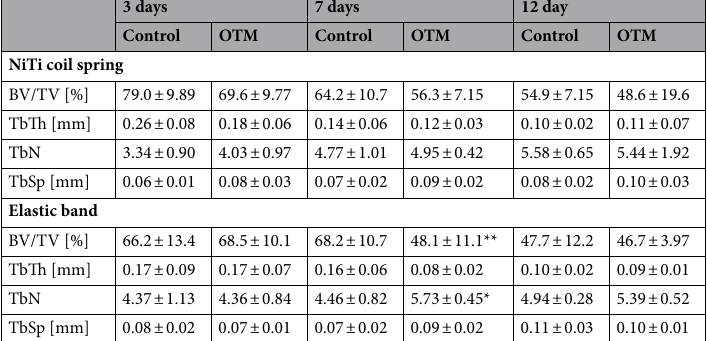
Effects of both methods for experimental OTM on bone morphogenetic factors. µCT evalu- ation showed a continuous, but insignificant decrease of the interradicular bone density (BV/TV) of the first upper left molar on the treated (OTM) as well as on the untreated side of the jaw over time (Table 1). Insertion of a NiTi coil spring showed no significant effect on BV/TV (F = 5.28, DF = 34, p = 0.001), trabecular thickness (TbTh, W = 5.7, DF = 15, p = 0.0040), trabecular number (TbN, F = 3.93, DF = 34, p = 0.0064) or trabecular spac- ing (TbSp, W = 3.0, DF = 16, p = 0.0502) at any investigated time point (Table 1). By contrast, insertion of an